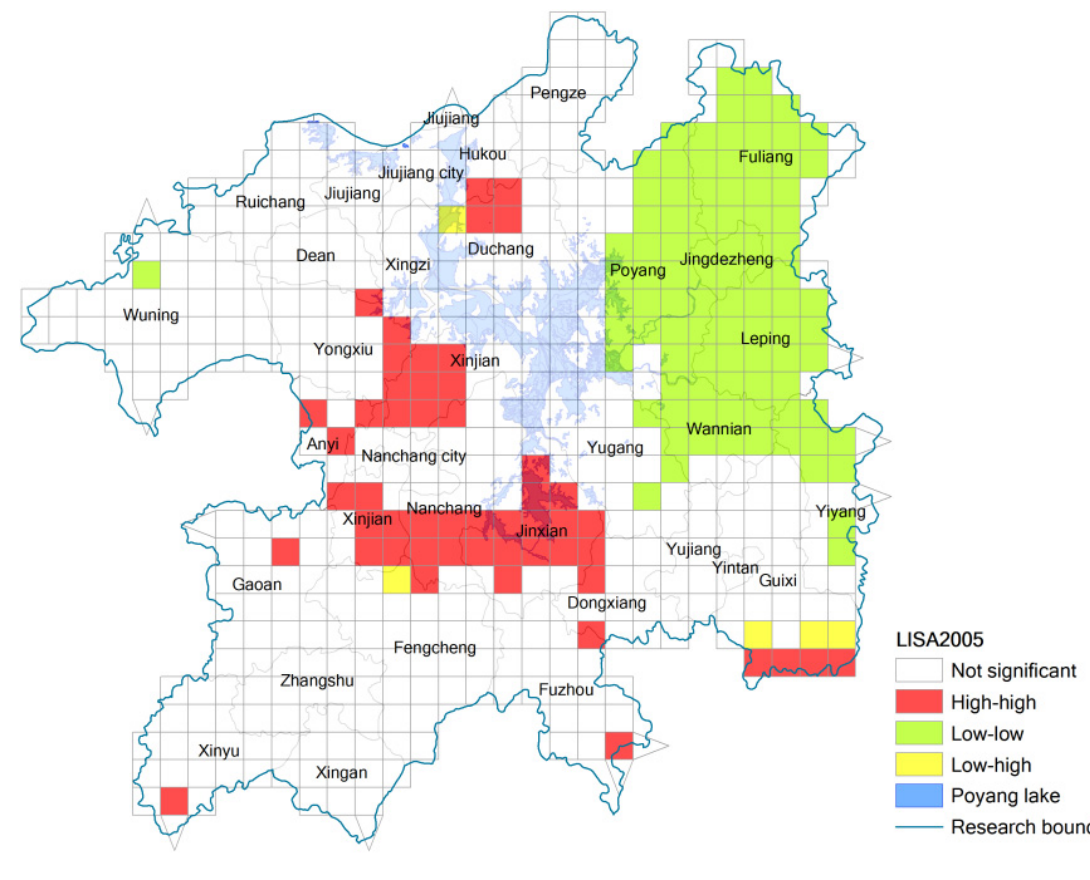
Figure 5. Locally spatial autocorrelation of eco-risk of the Poyang Lake Eco-economic Zone in